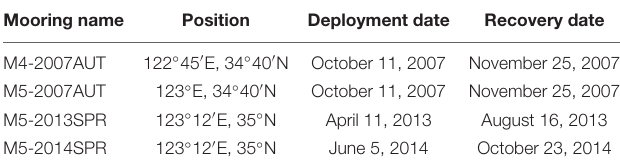
TABLE 1 | The bottom-mounted mooring information.